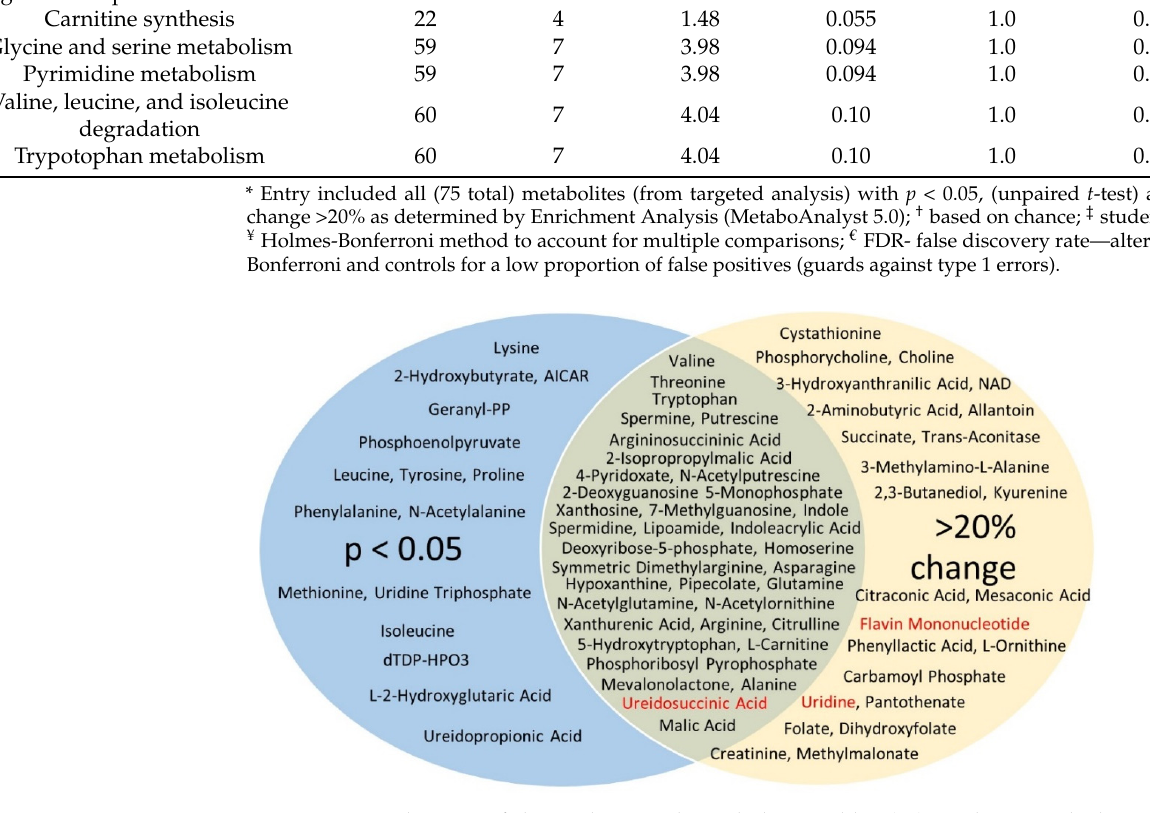
Figure 3. Venn diagram of changed targeted metabolites. In blue (16) are those in which p < 0.05 but were less than 20% changed; in yellow (24) are those that were greater than 20% changed, but p > 0.05; and the green overlap metabolites (35) satisfied both criteria. Those in red showed an increase with EMPA. All other (in black) were decreased.